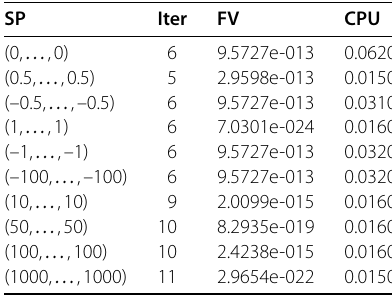
Table 1 Numerical results for Example 1